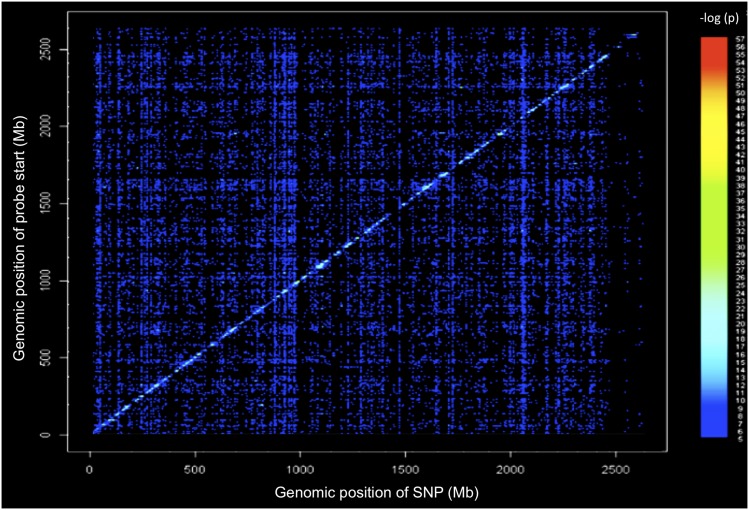
Cochlear eQTL plot. Diagonal line represents cis eQTLs. Dense vertical lines represent trans-eQTL hotspots. x-axis, expression SNP (eSNP) position; y-axis, probe position.